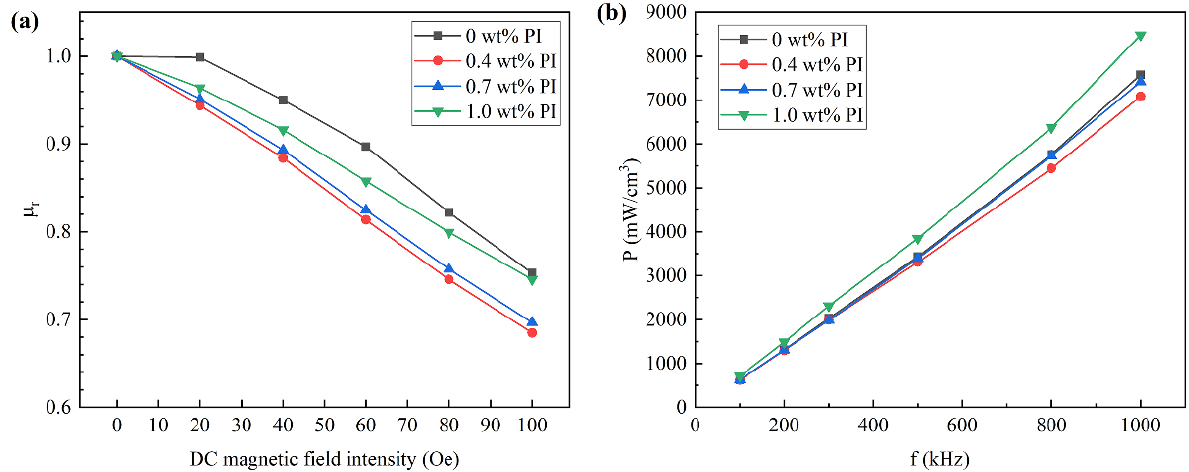
Figure 9. The trend of magnetic properties with PI content: ( a ) relative permeability; ( b ) core loss. Figure 9b is the core loss curve of Fe-Si-Cr SMCs coated with different PI contents.